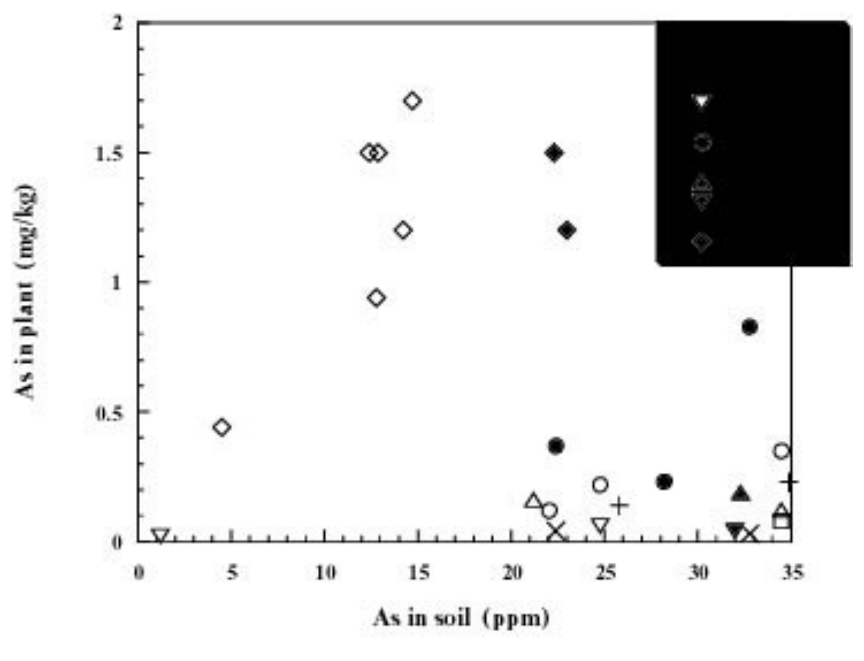
FIGURE 4. As concentrations of crop plants and soils from the study areas (crop plants from the Dukpyung area in open symbols and the Chubu area in closed symbols).